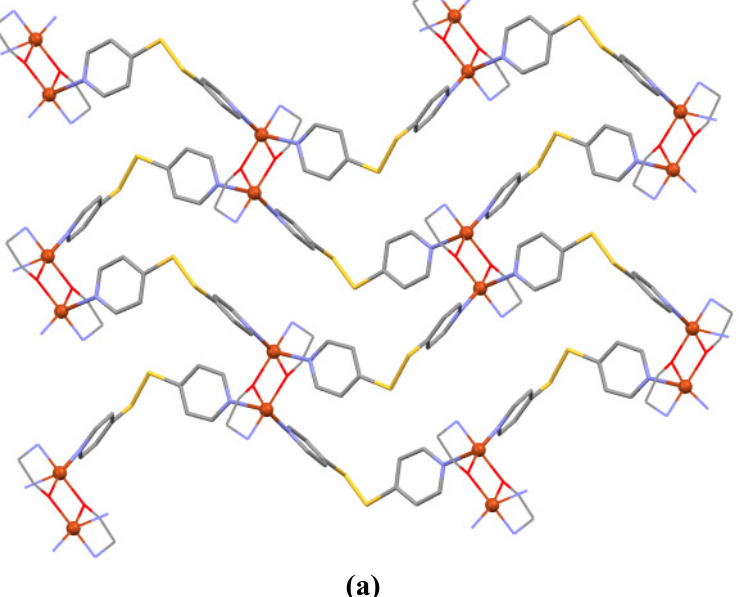
Figure 37. ( a ) Two-dimensional coordination network in [{Cu( μ -C ( μ - dtdp )}CF SO ·CH OH] (NOCJUL); ( b ) Superposition of the coordination networks of 3 3 3 n NOCJUL (red) and NOCKAS